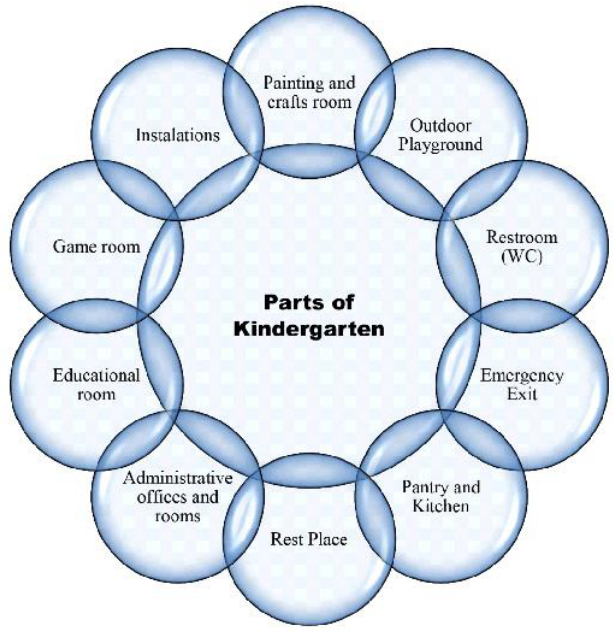
Fig. 3: The observed parts of kindergarten